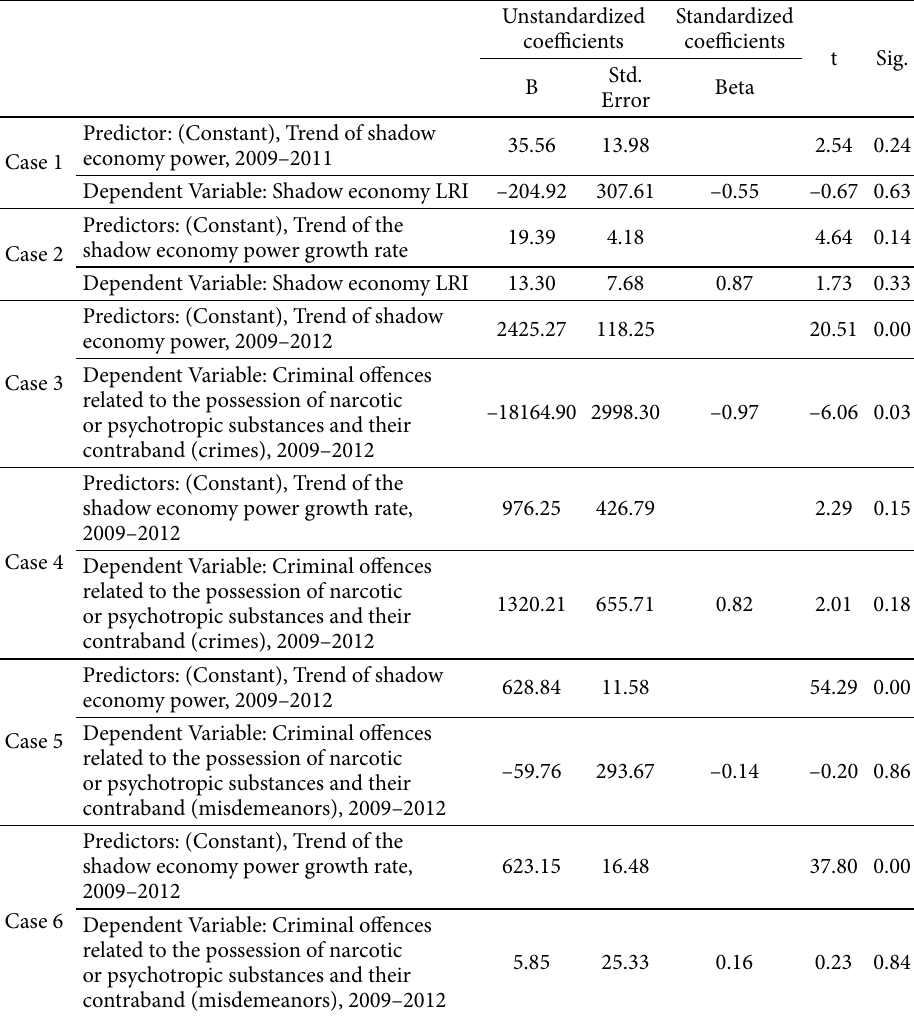
Table 11. Coefficients of shadow economy power and its